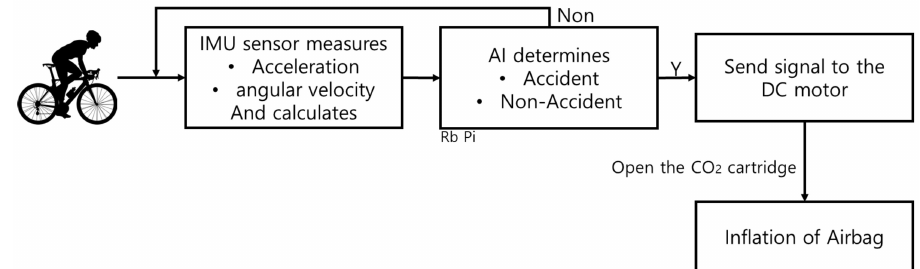
Figure 5. System diagram of the algorithm.